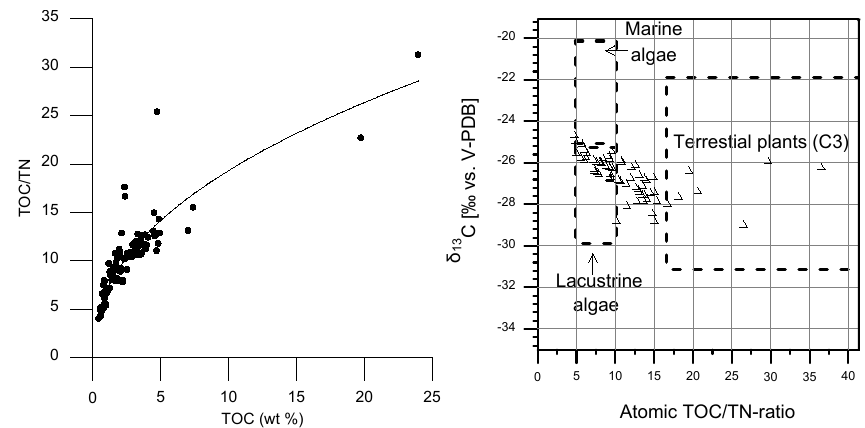
Figure 16. Organic matter characteristics of the Buor Khaya Yedoma. Left: correlation of the TOC content and the TOC / TN ratio. Right: distribution of the TOC– δ 13 C TOC relationships according to Meyers